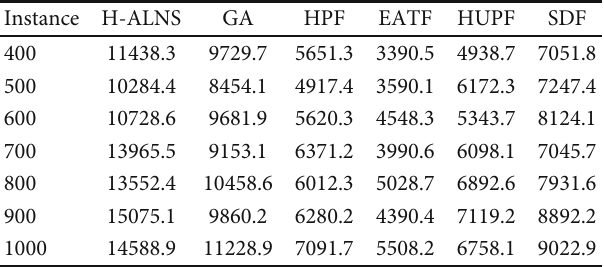
Table 5: Results of pro fi t under large-scale